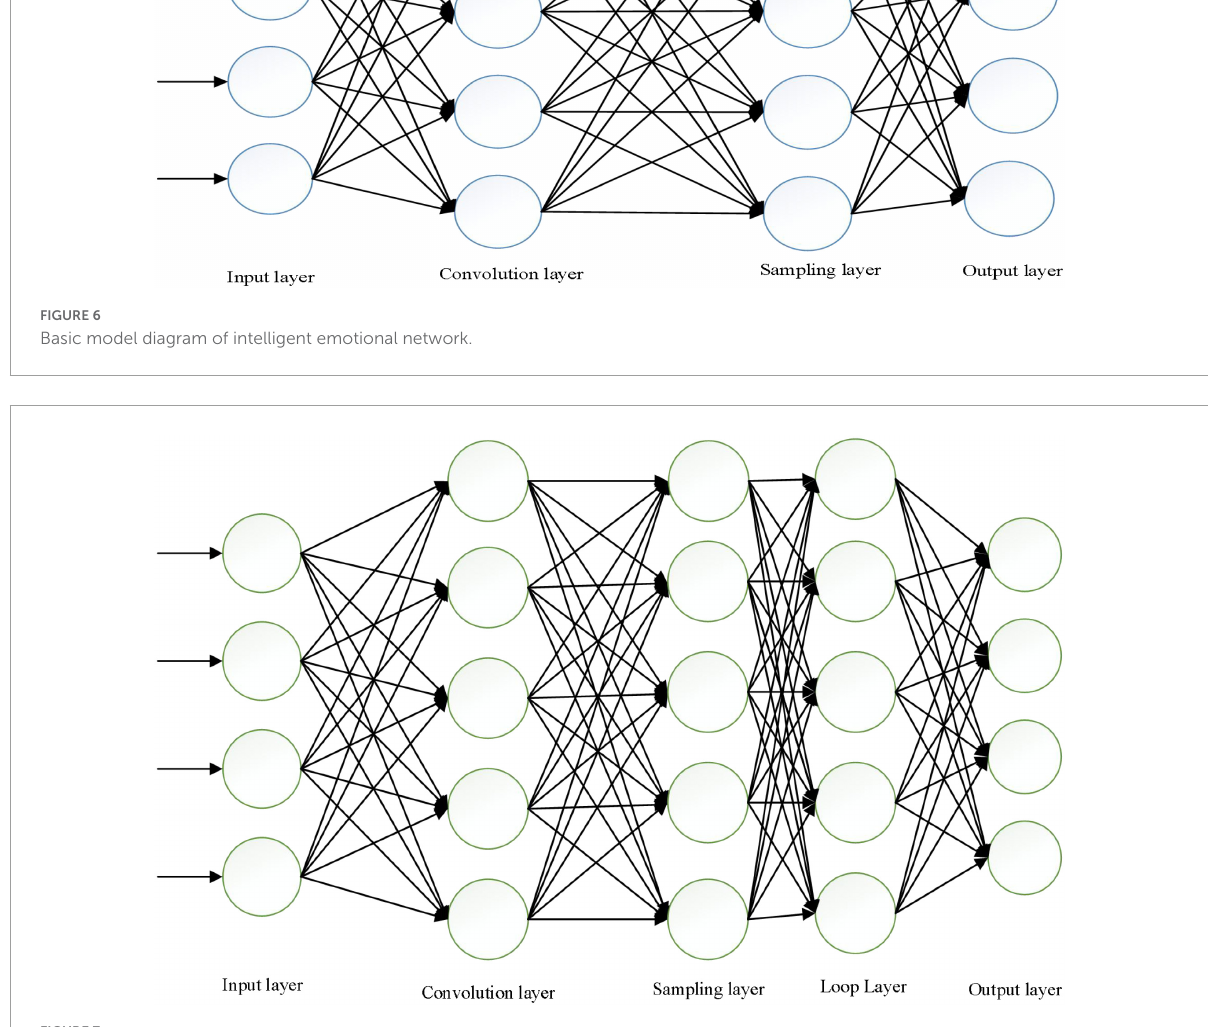
FIGURE7 Improved model diagram of intelligent emotional